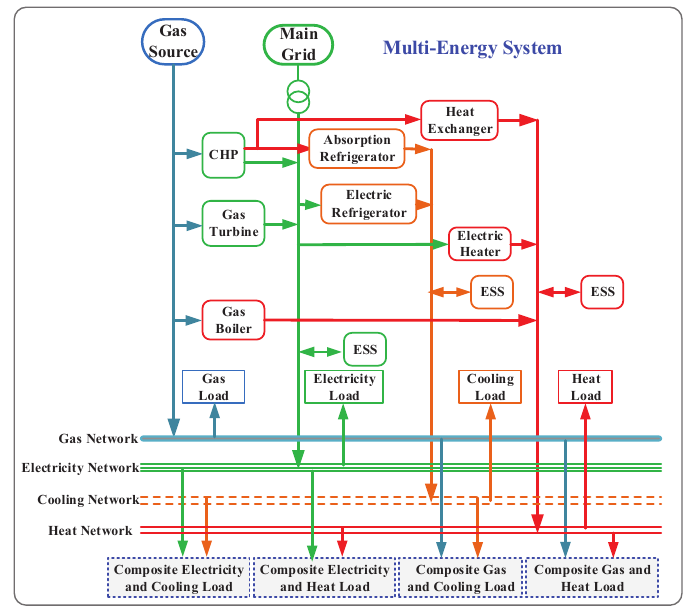
Figure 2. Schematic diagram of a multi-energy system (MES) consisting of gas, power, and cooling and heat networks. CHP = combined heat and power; ESS = energy storage